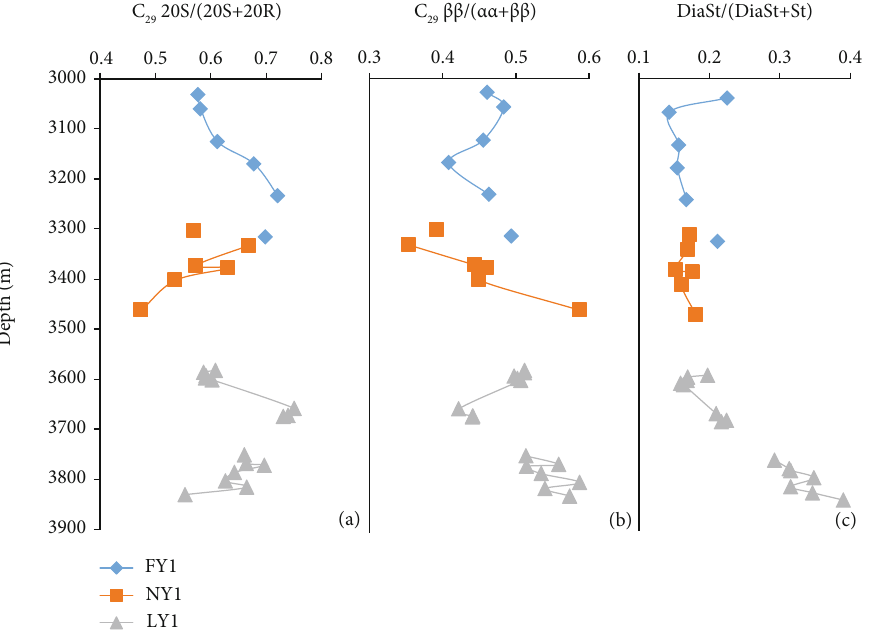
ααα 20S/ ð 20S + 20R Þ . (b) C αββ / ð αββ + ααα Þ . (c) 29 29